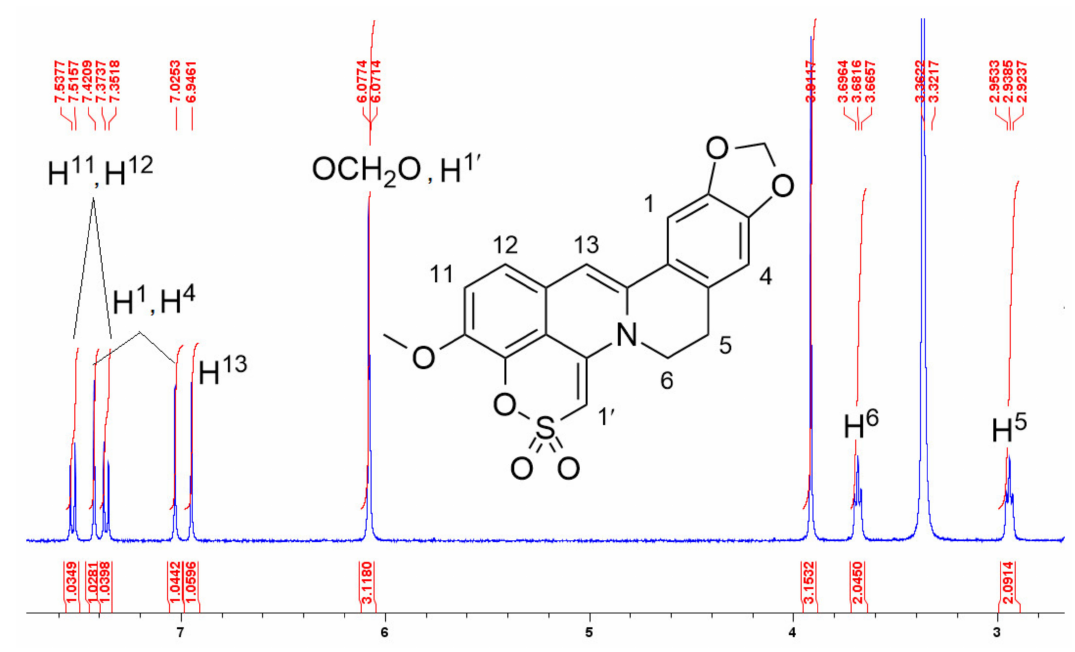
Figure 5. 1 H NMR spectrum of compound 16a